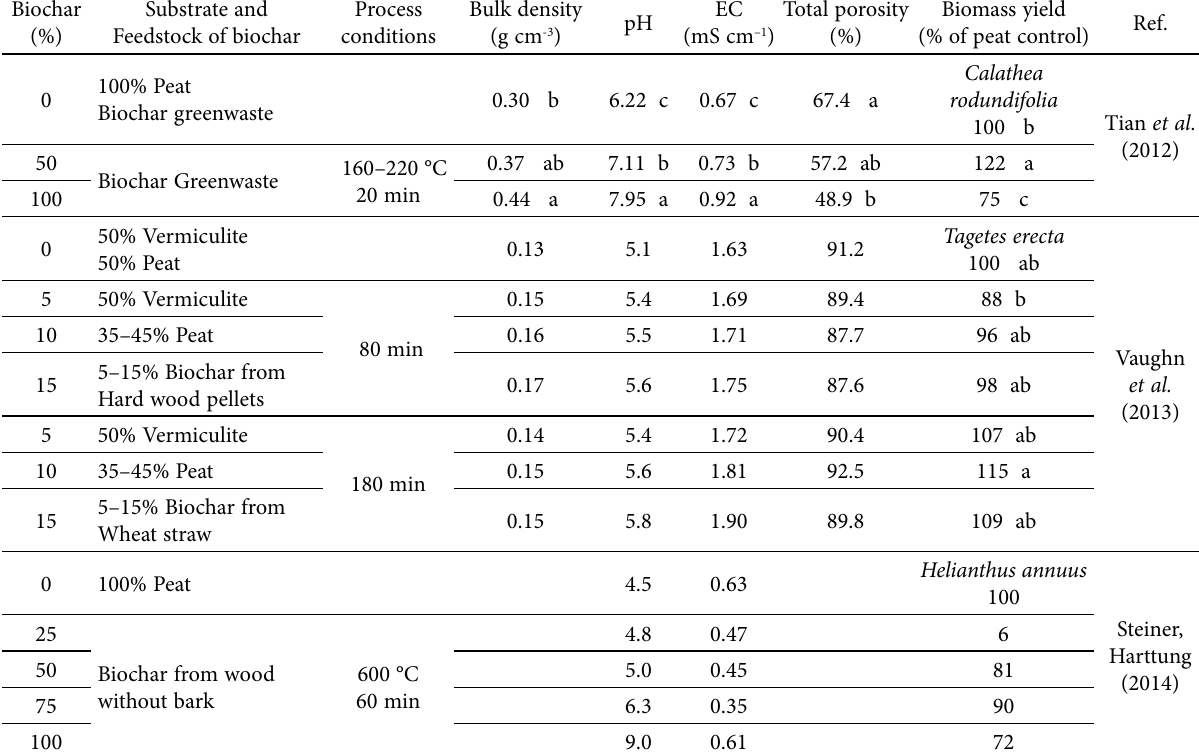
Table 5. Physico-chemical properties of soil-less plant growing media with variable peat and biochar amounts. Means within